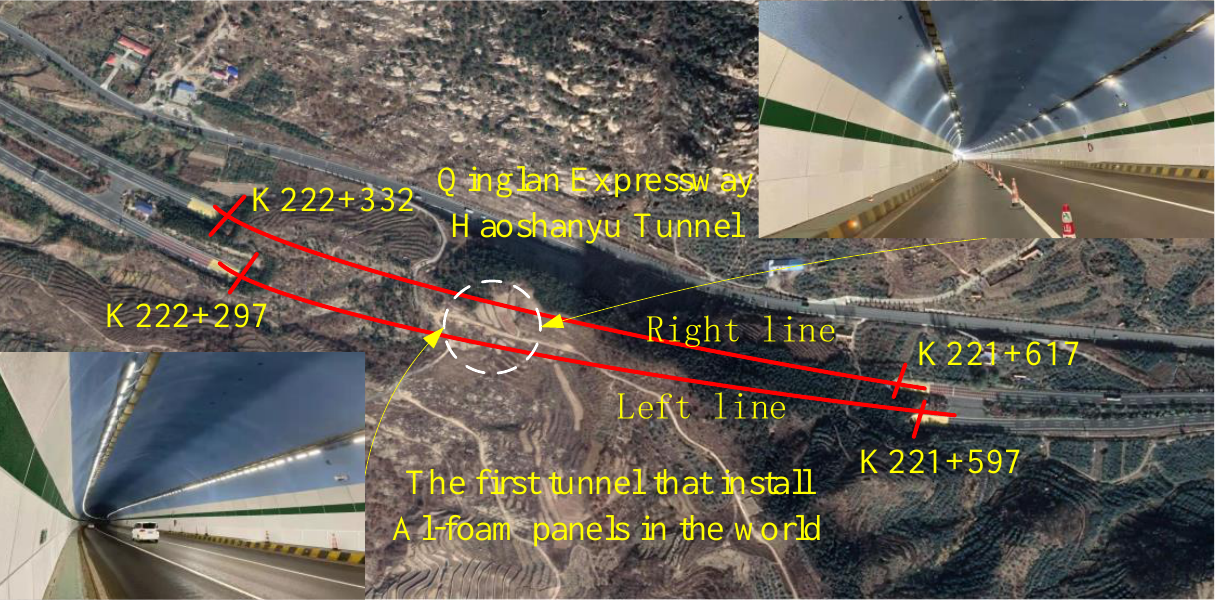
Figure 3. Traffic flow diagram of the Haoshanyu Tunnel. 3.2. Installation Method The aluminum foam board used in this project was prepared by melt foaming method, that is, adding tackifier and foaming agent successively in molten aluminum. The specific parameters of aluminum foam board are shown in Table 1. Due to the closed and disconnected pores in the closed aluminum foam board (Figure 4), the sound absorption performance is weaker than that of the open aluminum foam board. Therefore, it is nec- essary to improve its sound absorption performance through appropriate installation methods. Table 1. Performance index of aluminum foam. Parameter